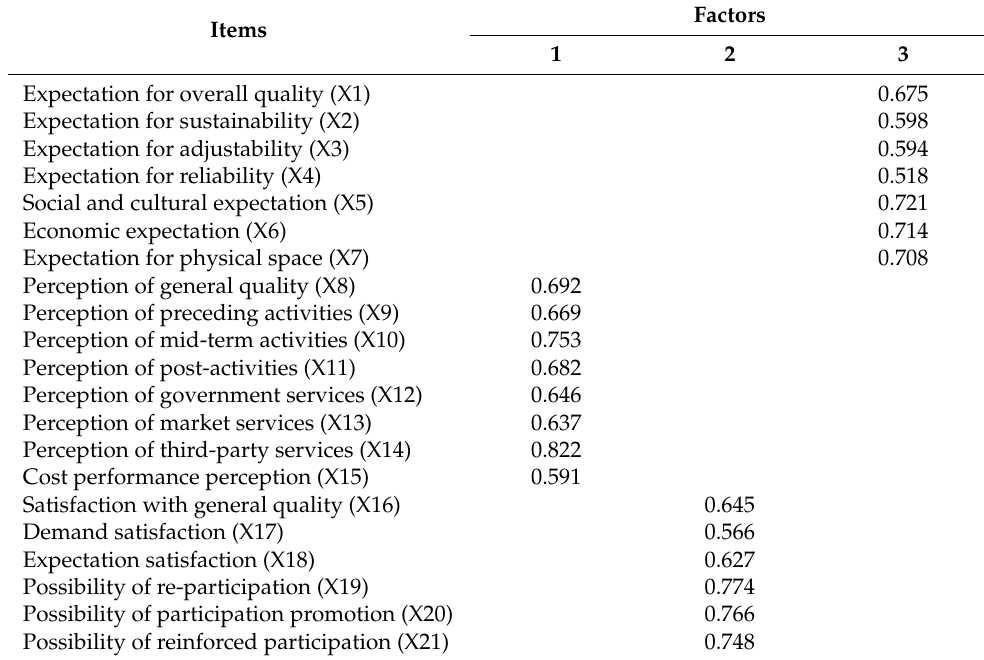
Table 4. Analysis of Exploratory